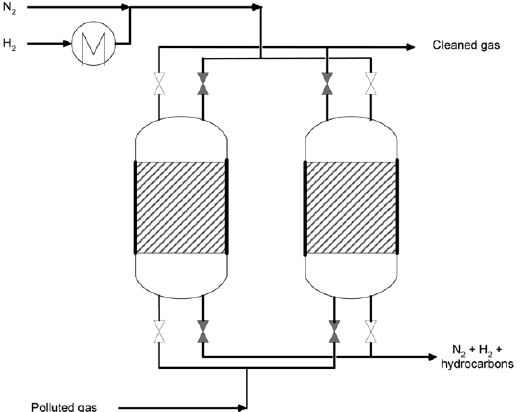
Figure 9. Scheme of adsorption / hydrodechlorination apparatus proposed by Elola et al. [234]: a first step of nitrogen flow in order to remove the oxygen, and a second step of hydrogen to hydrogenate the adsorbed chlorinated compounds. Reprinted with permission from ref. [234].